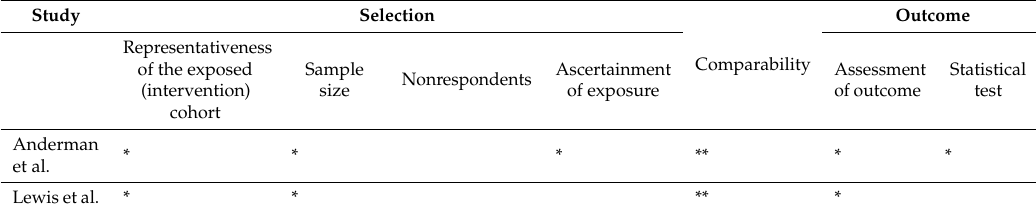
Table A1. Newcastle–Ottawa scale for cross-sectional studies (out of nine